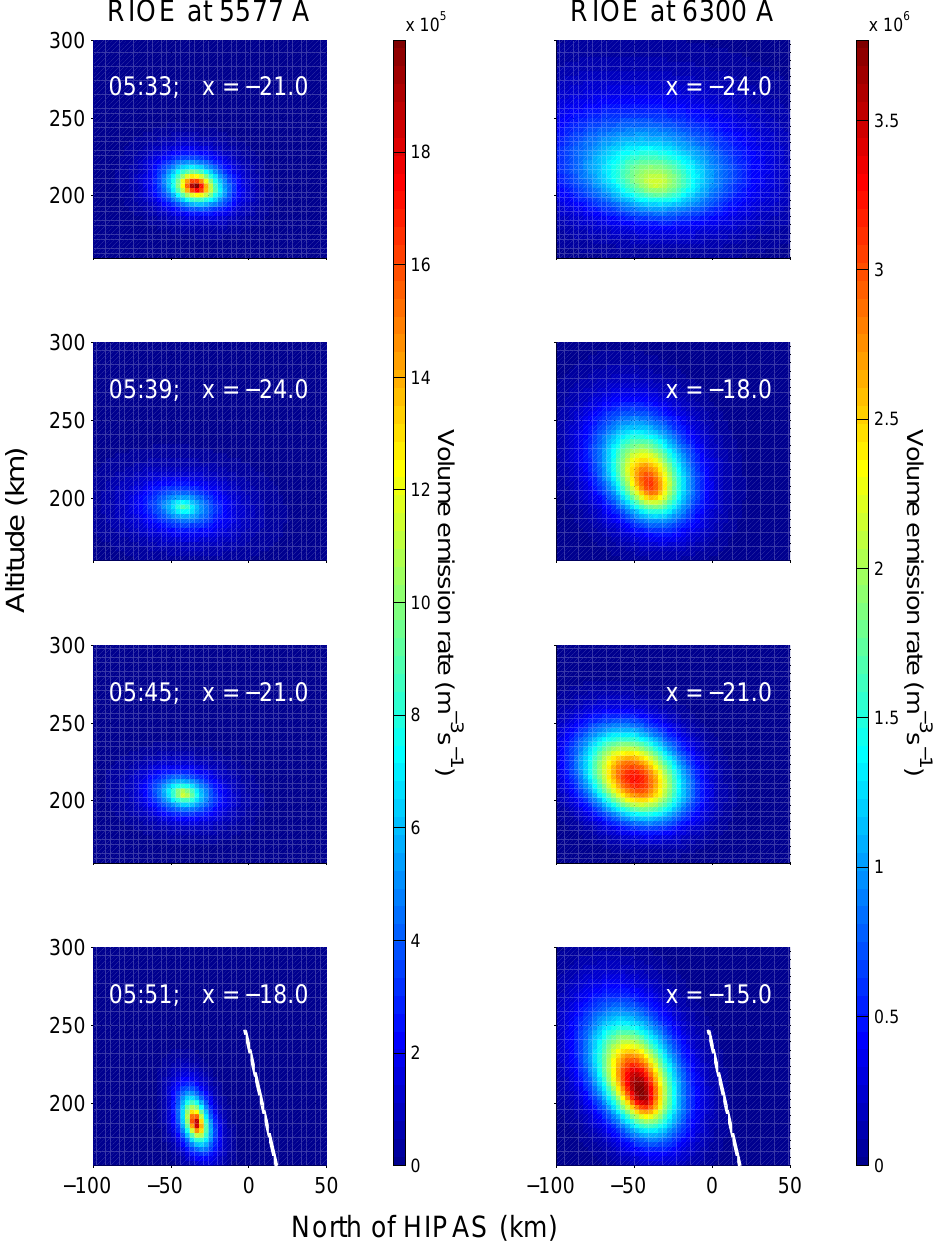
Fig. 9. The left and right panels show the vertical meridional cuts through the maximum of the enhanced volume emission at 5577 and 6300 ˚A, respectively, at the positions and times shown. Note that the region of enhanced volume emission rates extends to higher altitudes at 6300 ˚A. The white lines show the inclination of the magnetic